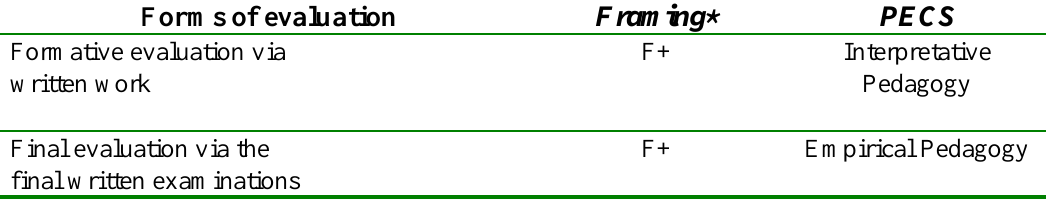
Table 3. Process of evaluation, framing and PECS Forms of